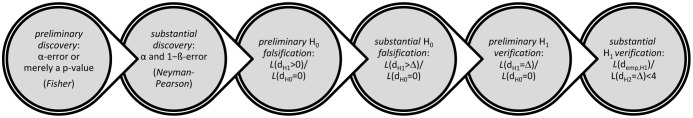
Salient results of a research program.